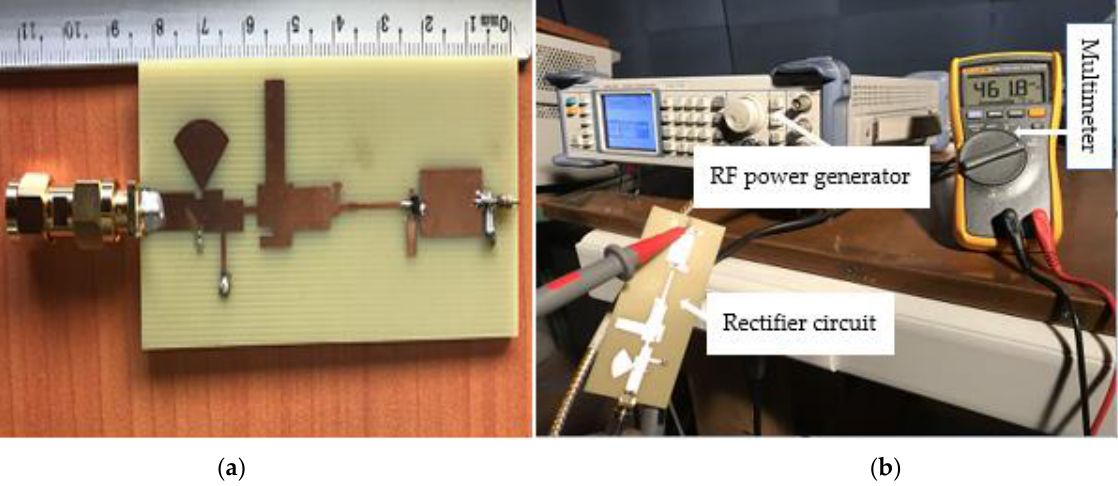
Figure 11. RF-to-DC conversion: ( a ) photo of the prototype of the manufactured rectifier; ( b ) experimental setup for the performance evaluation.